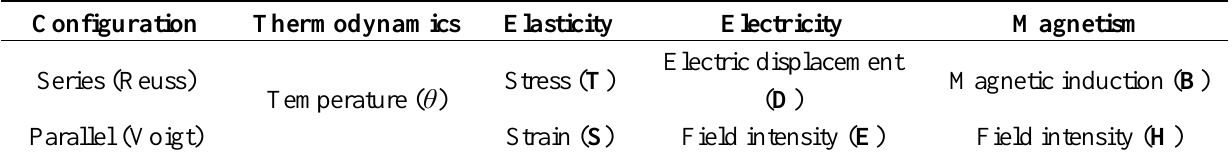
Table 2. Homogeneity conditions for physical magnitudes in polycrystal invariant